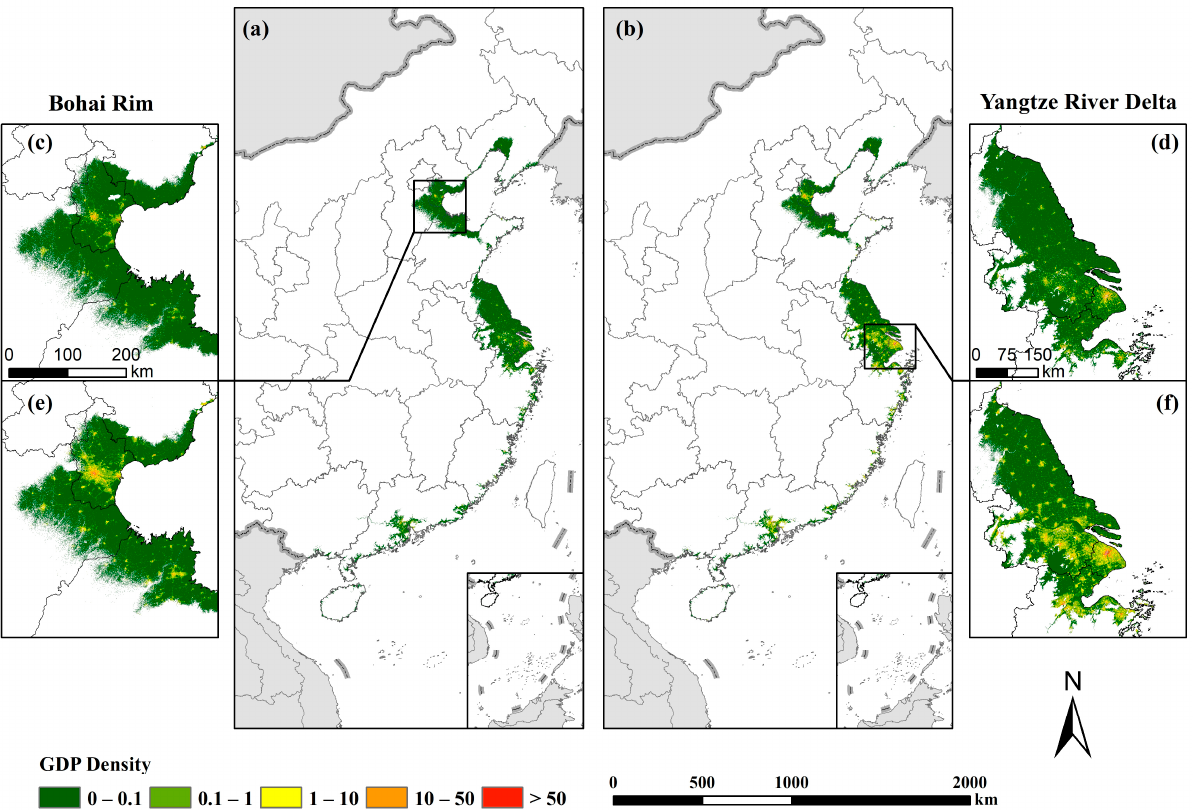
Figure 7. A 100 m gridded GDP 3 map of China’s LECZ in 2010 ( a , c , d ) and 2019 ( b , e , f ) (unit: million CNY/ha).